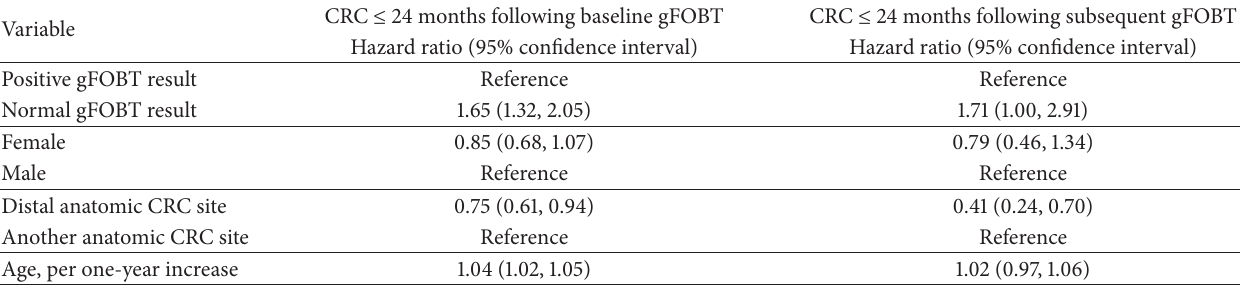
Table 4: Death from any cause following CRC by baseline and subsequent gFOBT